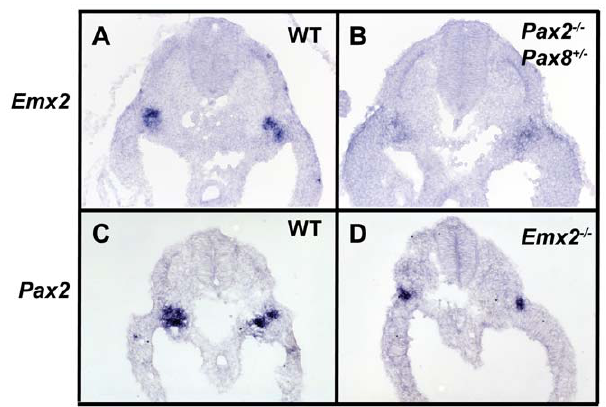
Figure 5. Genetic regulation of Emx2 by Pax2. (A–D) In situ hybridization on E9.5 sections for Emx2 (A,B), Pax2 (C,D) in wild-type (A,C), Pax2 -/- ;Pax8 + /- (B) and Emx2 + /- (D) embryos. Emx2 mRNA expression is significantly decreased in Pax2 -/- ;Pax8 + /- embryos, while